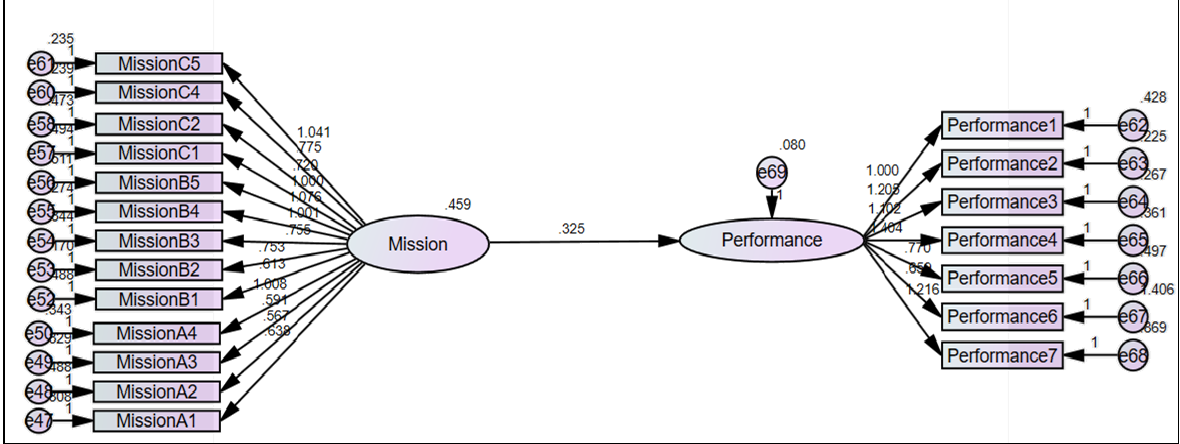
Figure 3: Path diagram on mission and performance; Source: Research Data 2018